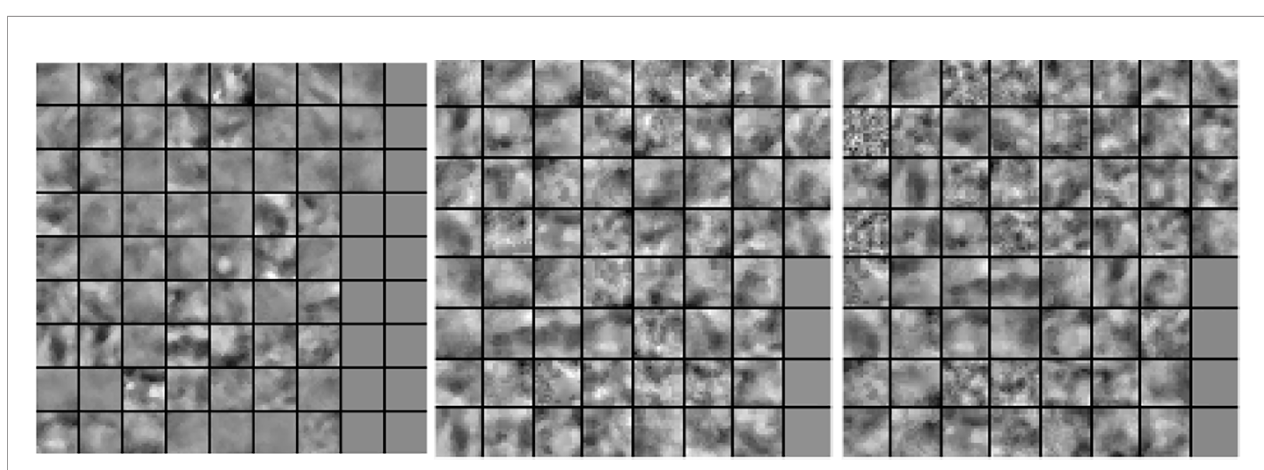
FIGURE 6 | Dictionary comparison example for SLESA without dictionary learning (left), LS-SLESA (middle), and LC-SLESA